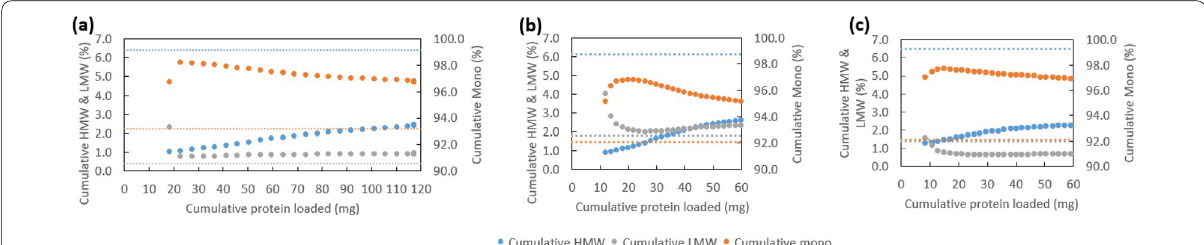
Fig. 4. 1-mL column validation runs of Capto Butyl ImpRes at the optimal condition of pH 4.0 for FabscFv-KiH ( a ) as well as Fab 2 scFv-KiH post-Protein A eluate with pH 4.3 wash ( b ) and pH 4.1 wash ( c ). The cumulative HMW (blue markers), LMW (grey markers) and monomeric (orange markers) species in the flow-through are represented as a function of the amount of bsAb loaded, with the initial percentage of each species represented in their respective colours in dotted lines